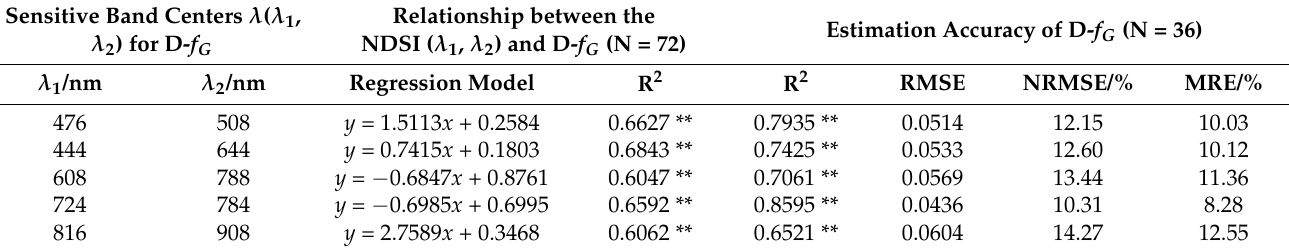
Note: In the fitted equation, x is the NDSI constructed by band λ 1 and band λ 2 , and y is the fitted winter wheat D- f G . N is the number of samples. ** indicates a very significant correlation at the level of p < 0.01.